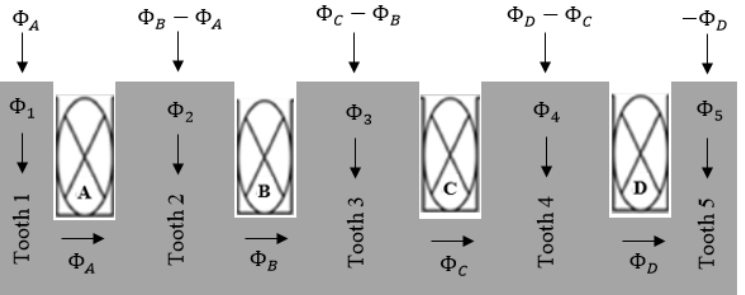
Figure 5. Flux paths for combined-phase TFM.